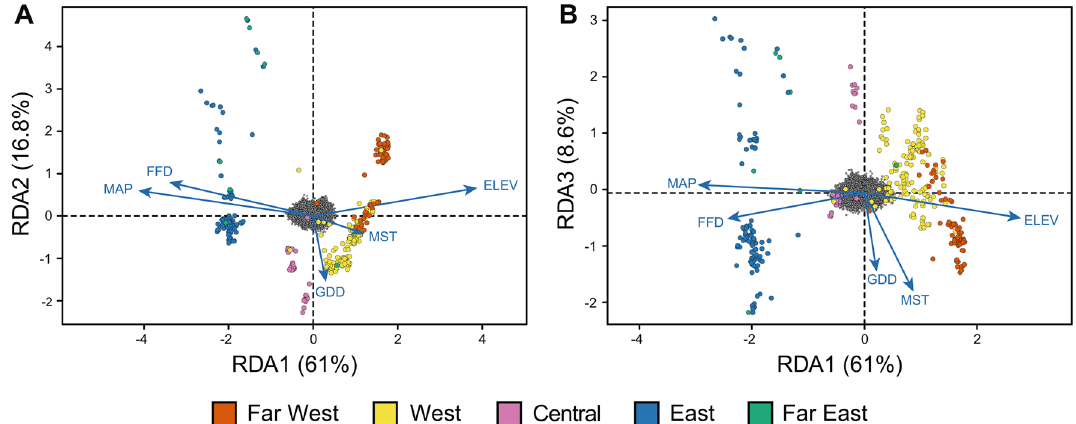
Figure 4. Redundancy analysis (RDA) ordination plots showing the relationship between population structure and environmental variables at the sites of origin along ( A ) RDA axes 1 and 2 (explaining 77.8% of the total variation), and ( B ) axes 1 and 3 (explaining 69.6% of the total variation). The dark grey cluster at the centre of each plot represents the 26,016 polymorphisms, while each dot represents a genotype (324 in total) , coloured by geographic cluster as shown in the legend. Blue arrows represent five environmental variables: mean annual precipitation (MAP), frost-free days (FFD), growing degree days (GDD), mean summer temperature (MST), elevation